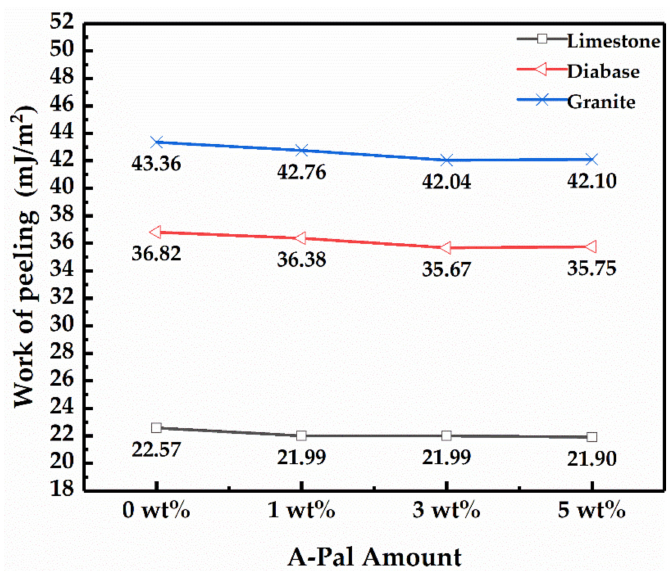
Figure 4. Peeling work of modified asphalt with different amounts of